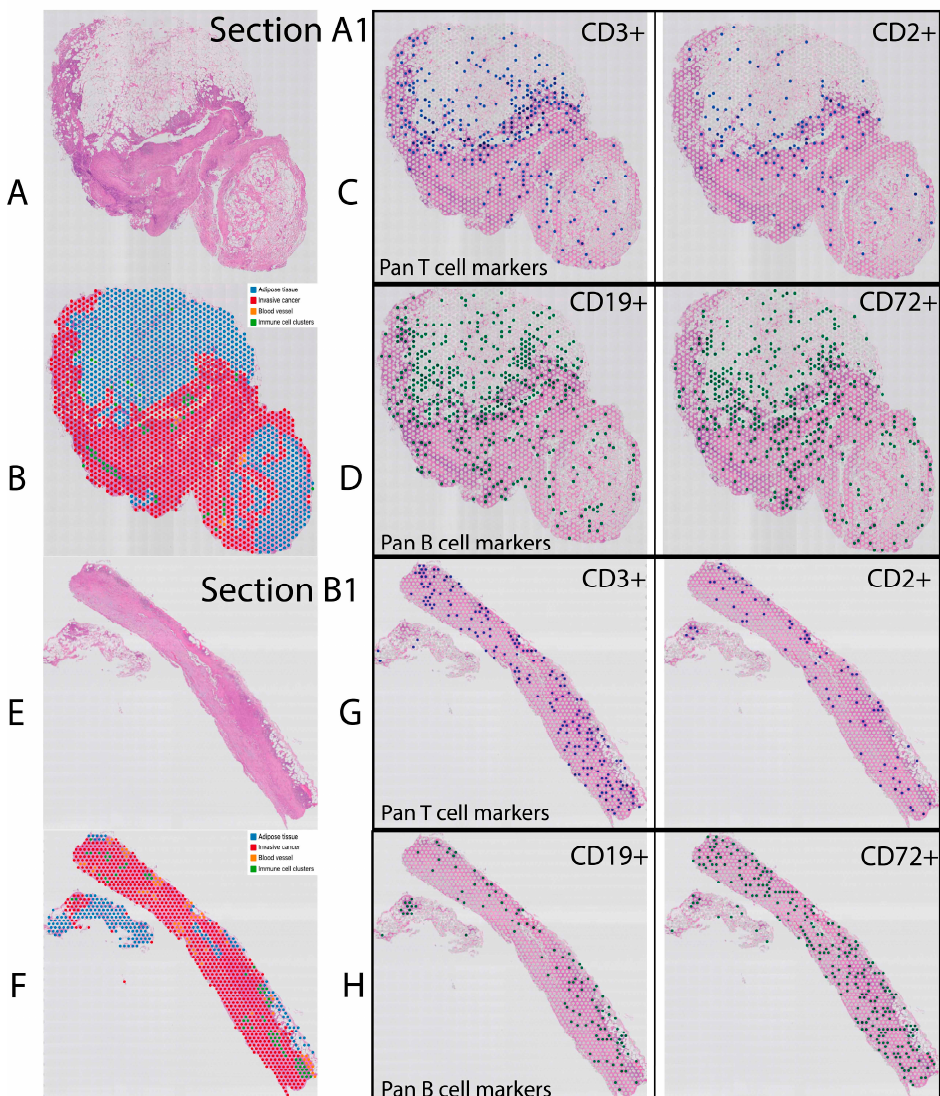
Figure 2. H&E and spatial images of analysed tissues using Loupe browser . H&E images of tissues A1 and B1 scanned with Olympus slide scanner ( A , E ) and pathologist’s annotation of tissues A1 and B1 in Loupe browser ( B , F ). To identify immune cells within the tissue sections, pan-T-cell ( C , G ) and pan-B-cell ( D , H ) markers were queried in Loupe browser. Discordance of spots assigned to T and B cells using pan-cell markers represent a major limitation of cells identification in Loupe browser.